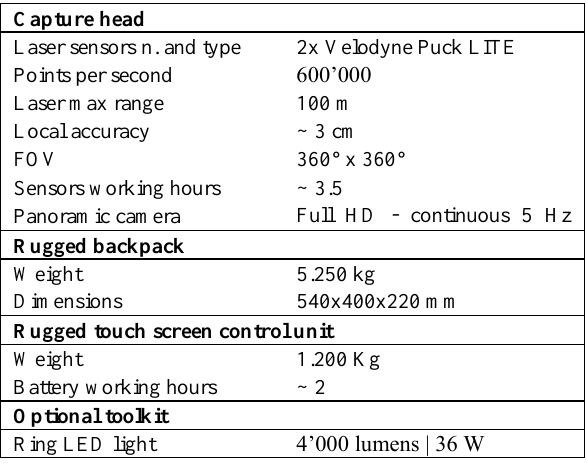
Table 2. Gexcel Heron MS Twin Color’s main